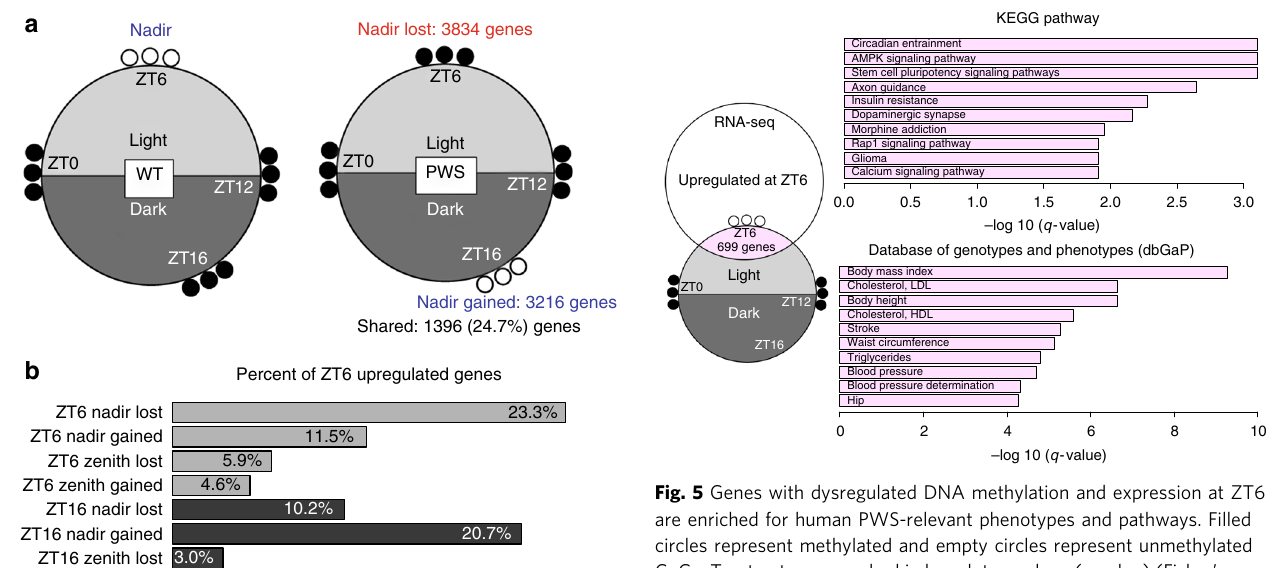
( p = 3.54 × 10 − 74 and p = 5.49 × 10 − 83 , respectively) and tran- scription factor binding sites in promoters and enhancers.